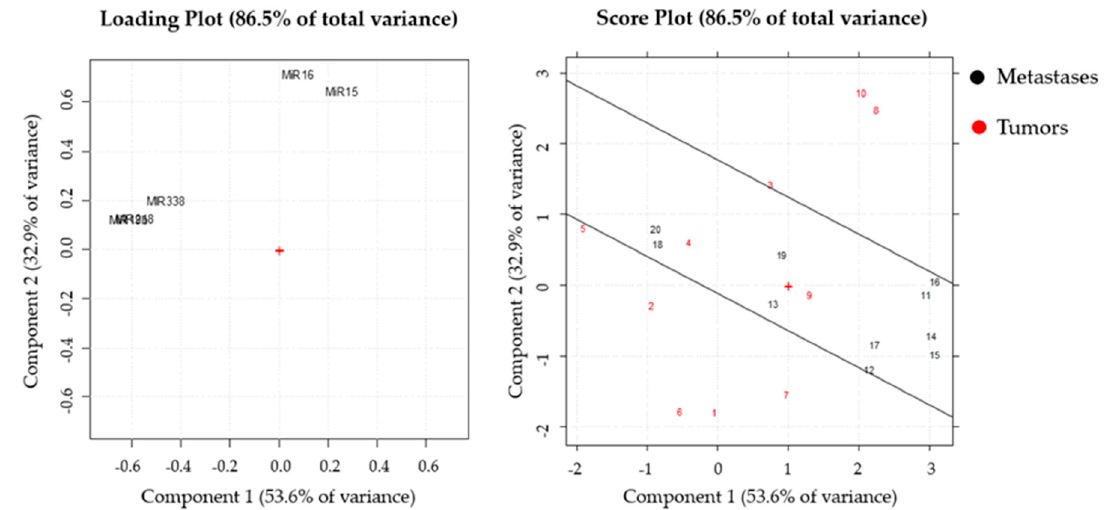
Figure 6. PCA performed on tumors and metastases samples. The loading (left panel) and the score plot (right panel) were reported. In the score plot, the samples were indicated by the number reported in Table 4. + represents the point with coordinates 0 and 0 for x and y axes, respectively. This points is the reference to define the multivariate space.